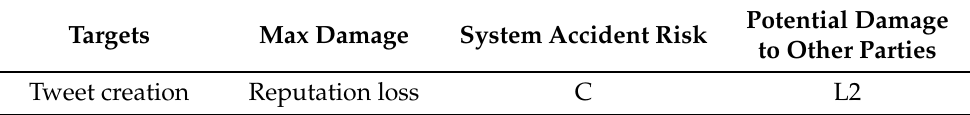
Table 14. System risks for Microsoft’s Twitter chatbot,